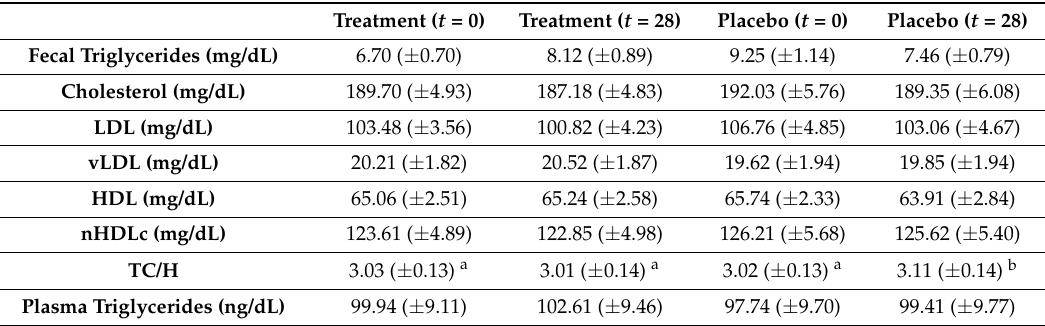
Table 1. Stool and plasma lipid profiles.